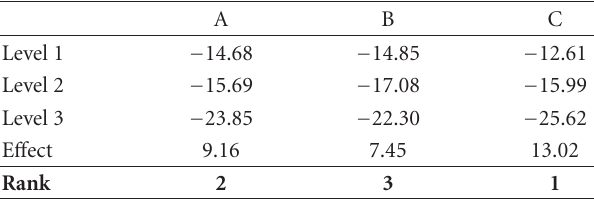
Table 5: Average e ff ect response for SN ratios.